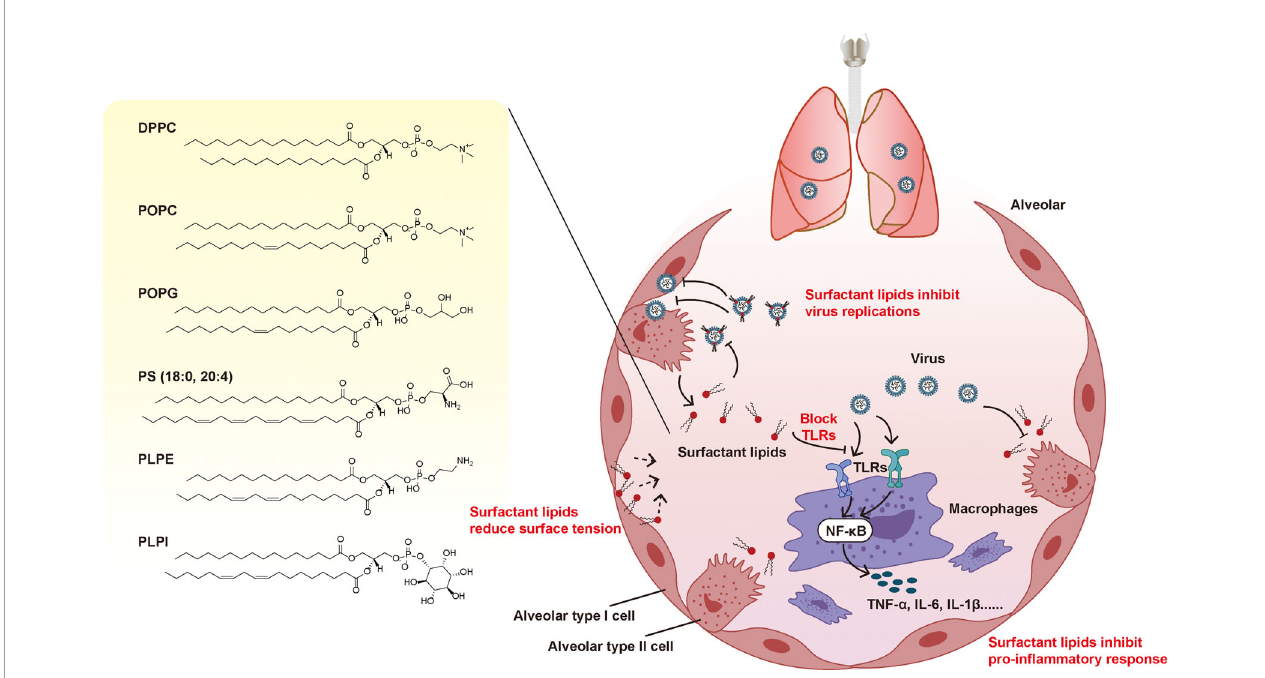
FIGURE 2 | Potential mechanism of PLs in therapeutic applications in respiratory viral infections. Respiratory viral infections can induce the dysfunction of pulmonary surfactant lipids. Supplement the pulmonary surfactant lipids may have therapeutic effects as follows: it may (1) supplement the decreased pulmonary surfactant lipids; (2) reduce surface tension and prevent alveolar collapse during respiratory activity; (3) inhibit the proin fl ammatory response and alleviate tissue damage in lungs; and (4) inhibit virus replications and limit virus